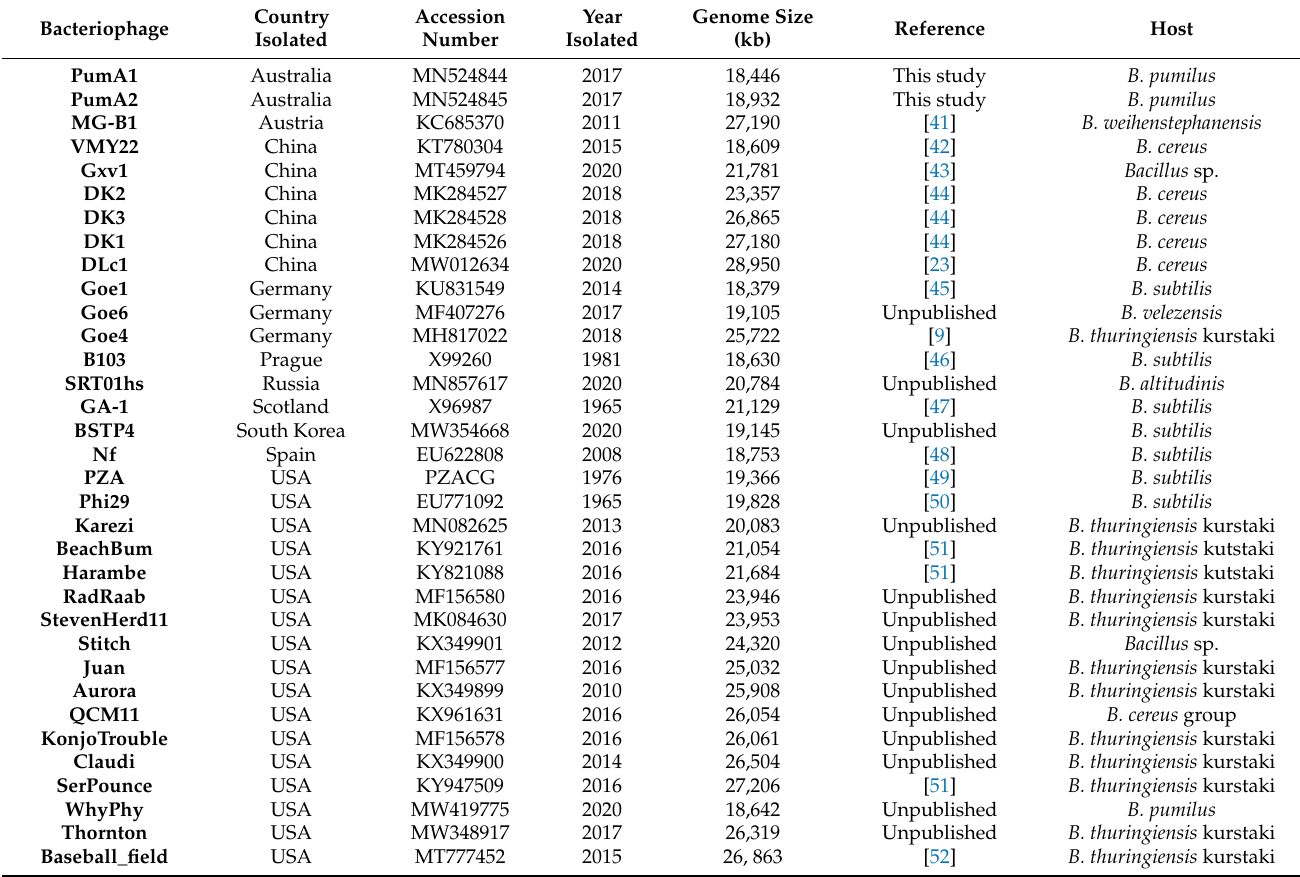
Table 1. Current Salasmaviridae (phi29-like) phages that have been sequenced and submitted to the Genbank and Bacillus phage database as of February